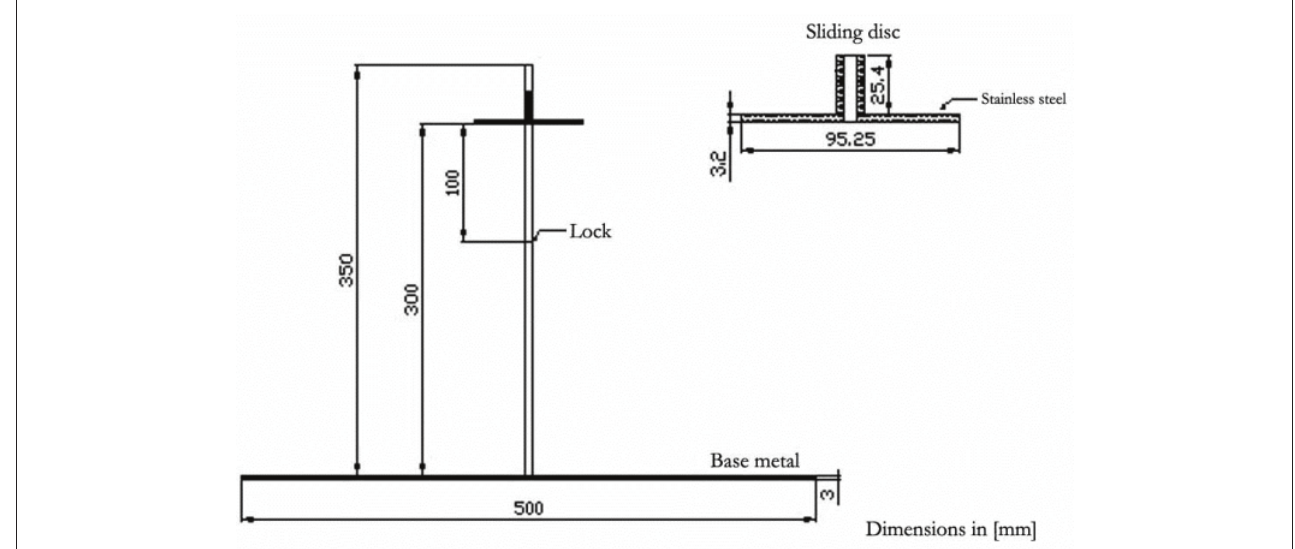
Figure 2 – Device of the modified slump test. Rod in the center of the metal base and the sliding